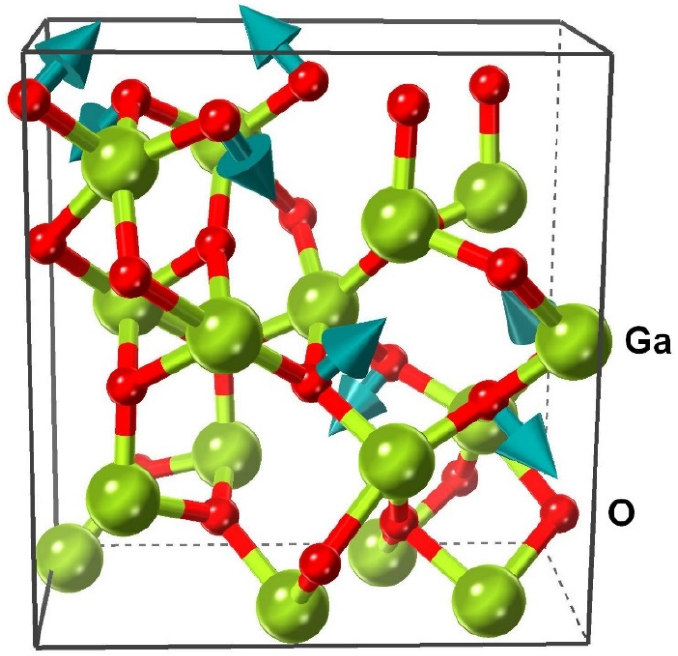
Figure 11. Directions and relative amplitudes of oscillations of atoms in ε -Ga 2 O 3 , as calculated in the DFT framework for the main line No. 5 of the Raman spectrum (Figure 10a,b). Only one cell having the Pna 2 1 symmetry is shown; z-axis is directed upwards.